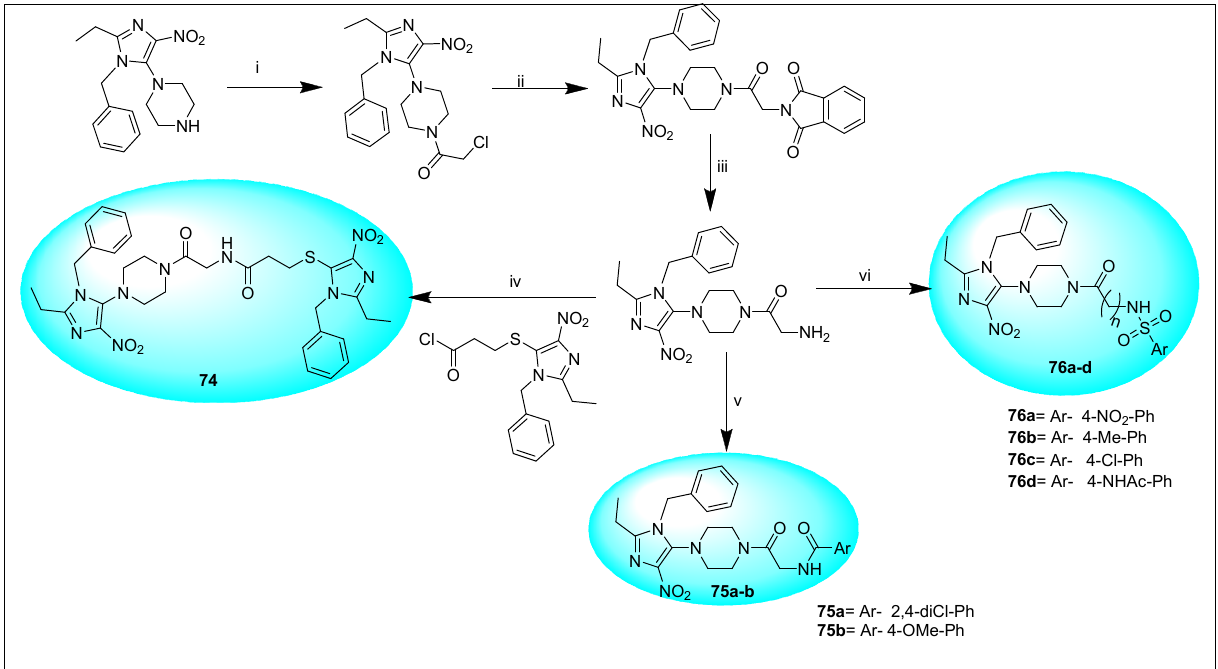
Scheme 20. New method for the C-amination of 1-methyl-4-nitroimidazole. Reagents and conditions: t -BuOK(MeONa), DMSO, rt, 22 h, 56%. Al-Masoudi et al. developed new-generation 5-substituted piperazinyl-4- nitroimidazole derivatives ( 74 – 76 ) as anti-HIV agents (Scheme 21). [90] The analog 76c was found to selectively inhibit HIV-1 replication.